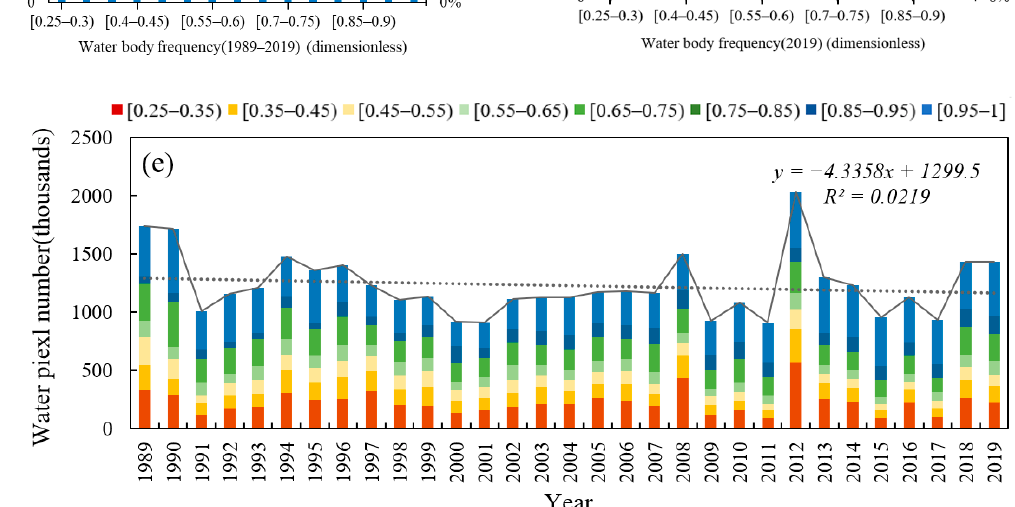
Figure 5. The water body frequency distribution in the Hetao Plain: ( a ) Water body frequency distribution map from 1989 to 2019; ( b ) water body frequency distribution map in 2019; ( c ) number of pixels with a di ff erent water frequency in the interval of 0.05 from 1989 to 2019; ( d ) the number of pixels with a di ff erent water frequency in the interval of 0.05 in 2019; ( e ) the number of pixels distributions of a di ff erent water frequency in the interval of 0.1 from 1989 to 2019.